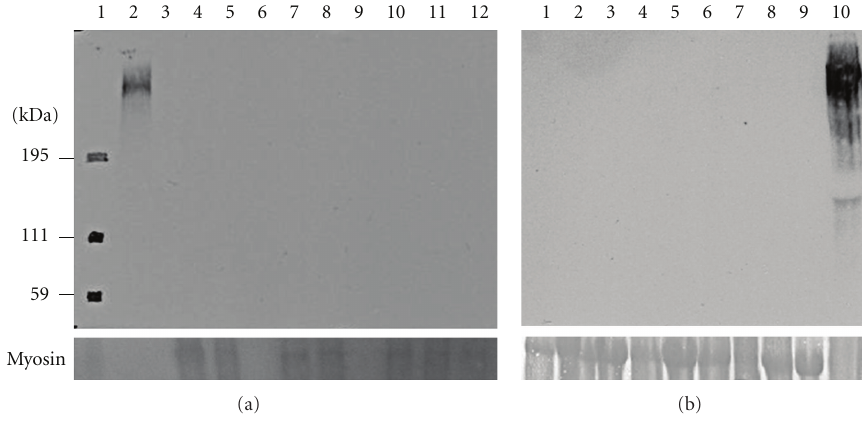
Figure 3: Dystrophin expression analysis. Western blot using antidystrophin rod-domain DYS1 antibody. Samples shown are the following: (a)(1) kaleidoscope protein standard; (2) wild-type canine muscle; (3, 6, 9) blank; (4, 5) B144 and B312 from a ff ected male L3M6; (7, 8) B144 and B312 from a ff ected female L3F1; (10, 11) B144 and (12) B312 from a ff ected female L3F2. (b) (1) Biceps femoralis; (2) biceps brachialis; (3) triceps brachialis; (4) quadriceps femoralis; (5) tibialis cranialis; (6) diaphragm; (7) sartorius; (8) gastrocnemius; all from a ff ected male L3M6 at necropsy. (9) GRMD muscle; (10) wild-type canine muscle. Myosin content in the Ponceau S prestained blot was used to assess the amount of loaded proteins.